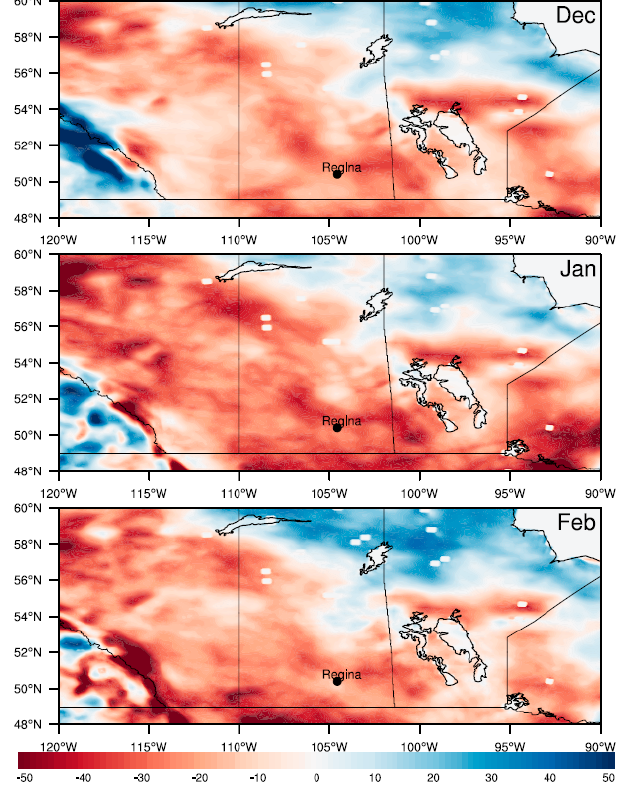
Figure 8. WRF simulated difference (ELX-LAX) in snow depth (cm) for winter.